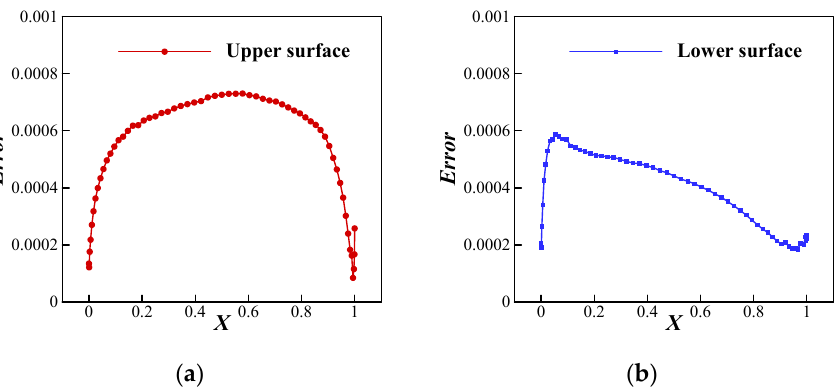
Figure 10. Error distribution at the predicted points along the chord-wise direction of ( a ) upper surface and ( b ) lower surface.